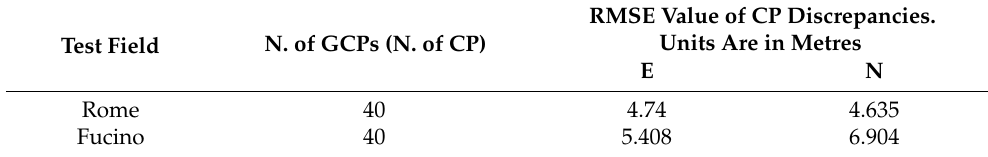
Table 12. Accuracy achieved with 40